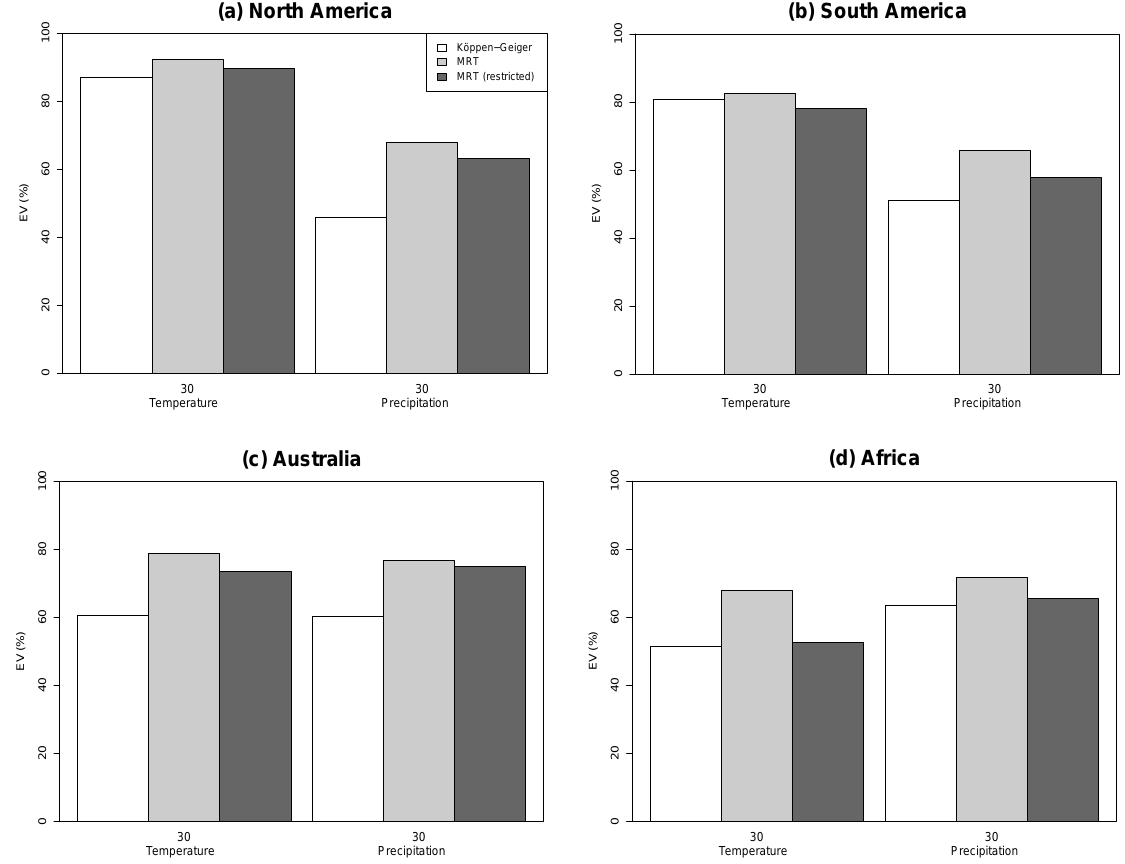
Fig. 10. Average monthly EV values for K¨oppen-Geiger, MRT, and restricted MRT climate classifications for temperature and precipitation variables at grid (d)